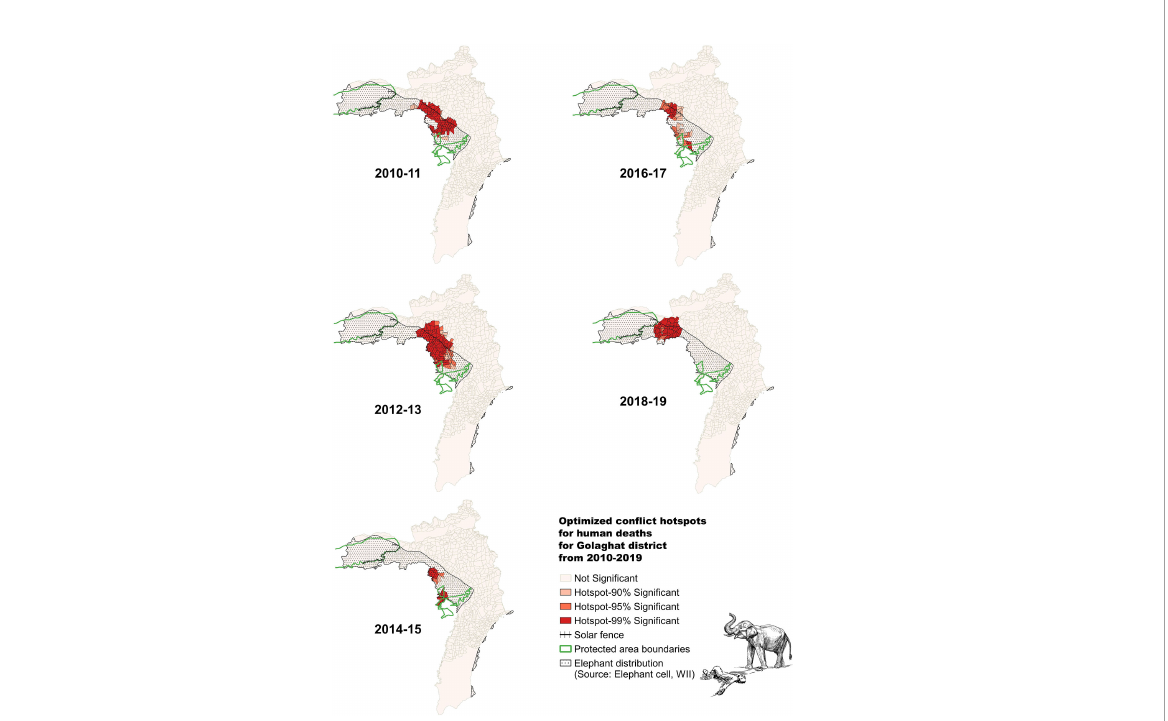
FIGURE 4 Con fl ict distribution and dispersion over the time period between 2010 and 2019 in the form of optimized human death hotspots for Golaghat